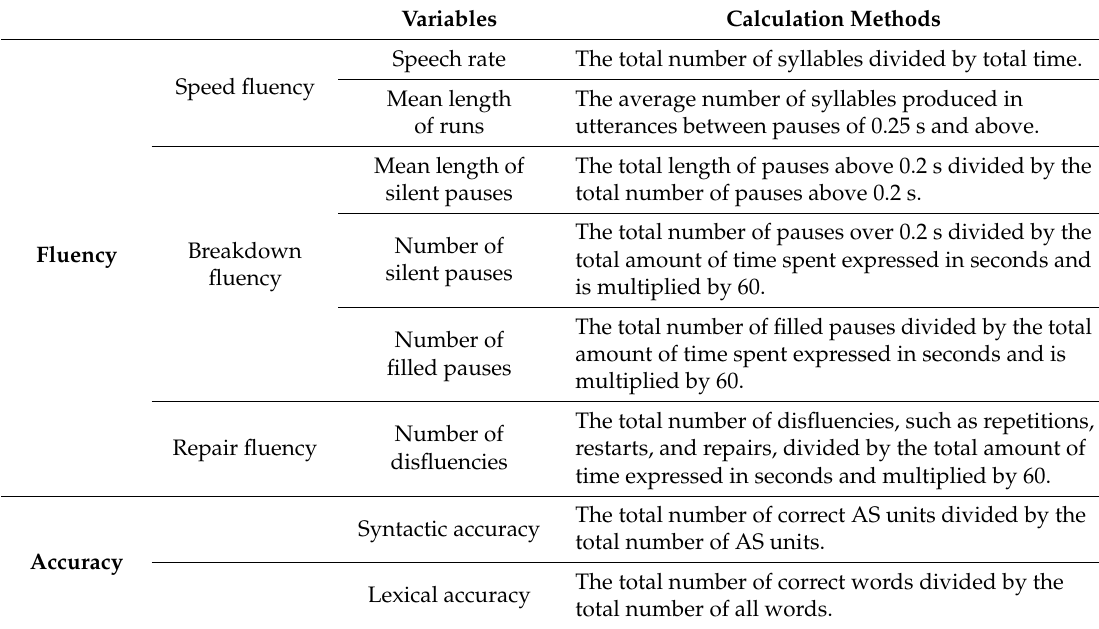
Table 1. Measures of speaking performance and their calculation methods.